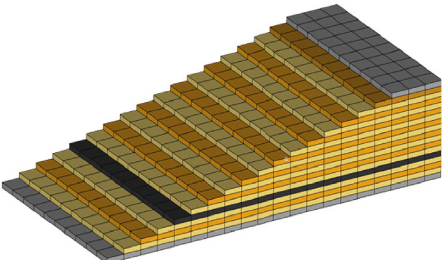
Figure 6: Composite multilayer floor structure